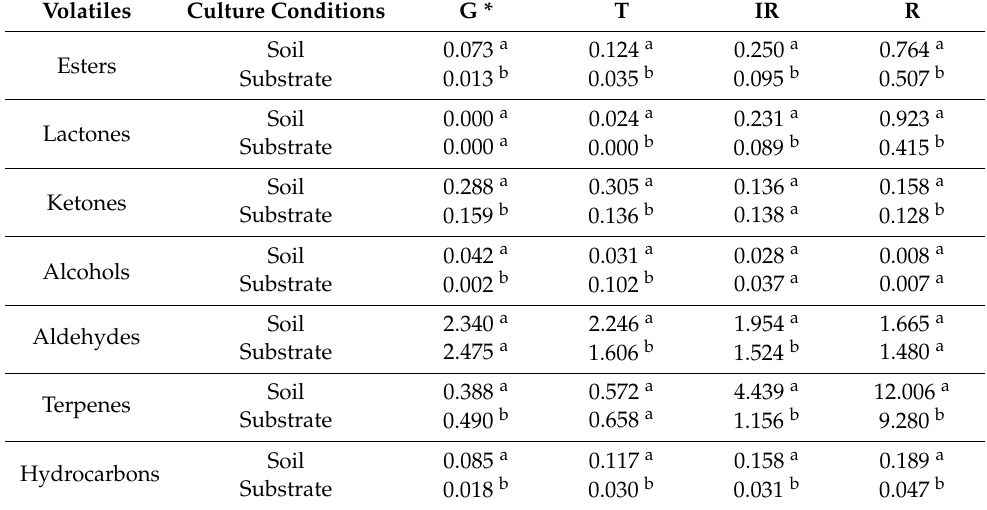
Table 1. Content of aroma volatiles ( µ g/g FW) in apical section of ‘Amaou’